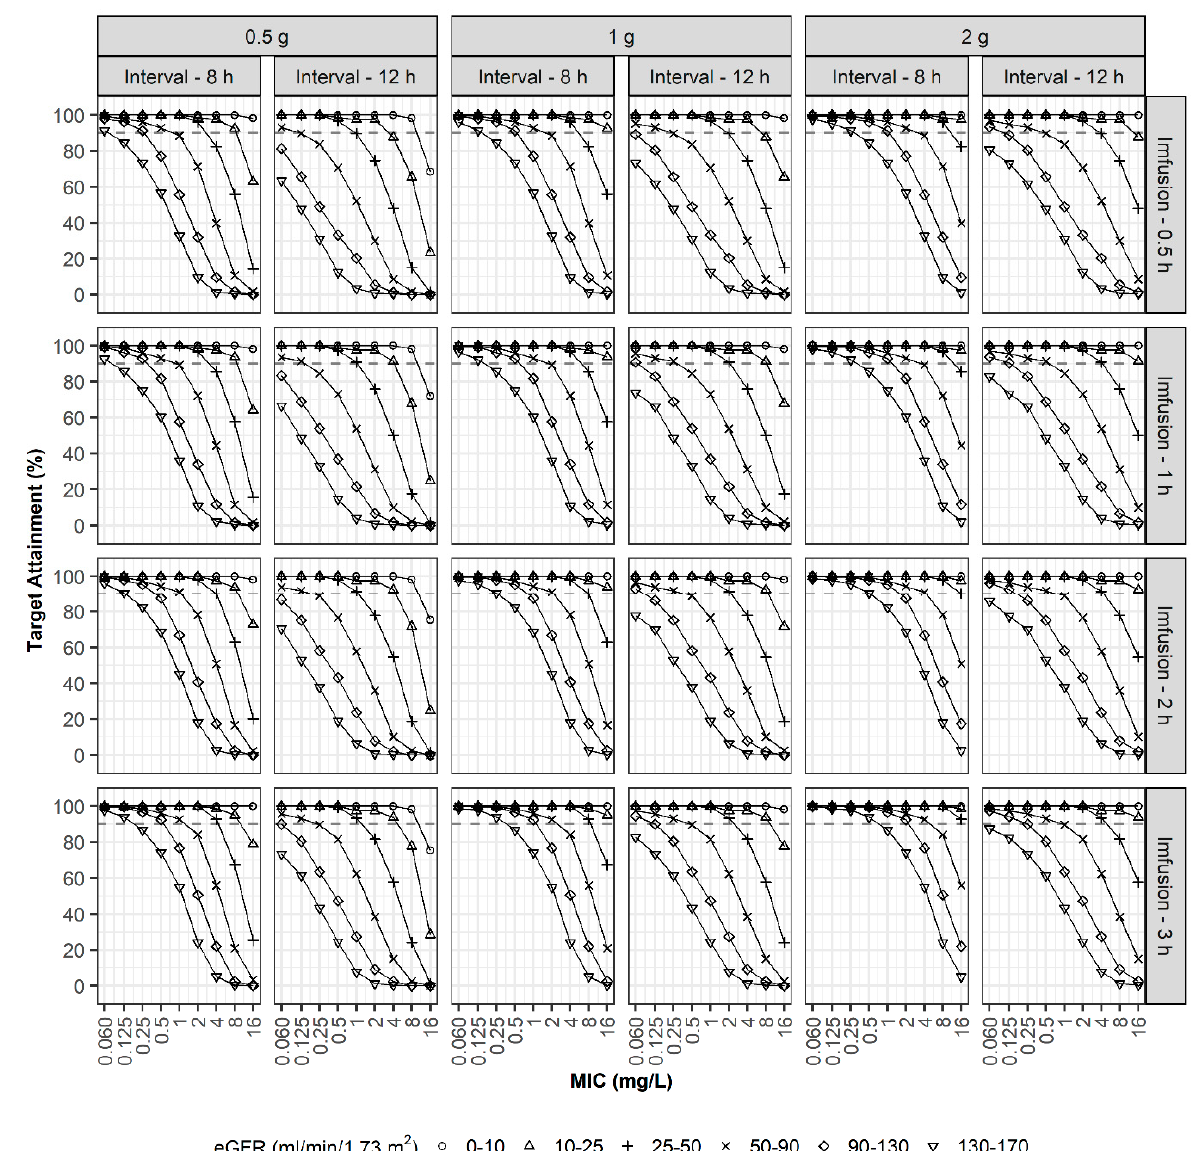
Figure 5. PTAs (100% f T >MIC ). Simulation results with three doses (0.5, 1, and 2 g), two dosing intervals (8 and 12 h), four infusion times (0.5, 1, 2, and 3 h), various degrees of renal function, and various MICs.